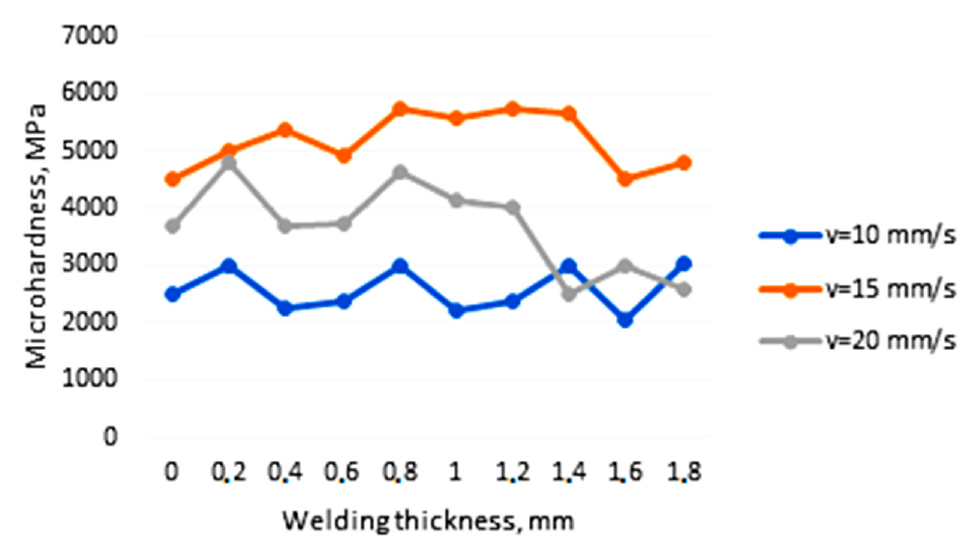
Figure 5. Measurement of microhardness by the thickness of the deposited layer at different surfac- ing speeds.